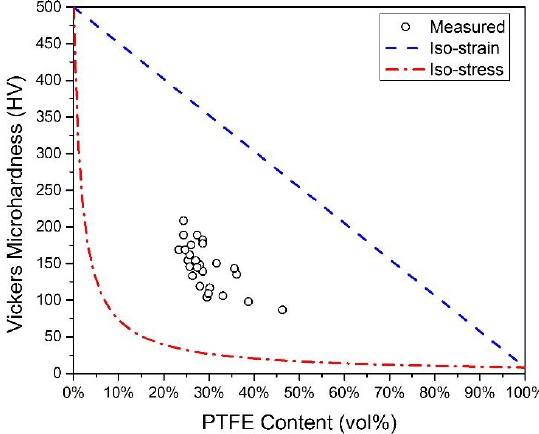
Figure 11. Effect of PTFE on the Vickers microhardness of Ni-PTFE composite coatings.